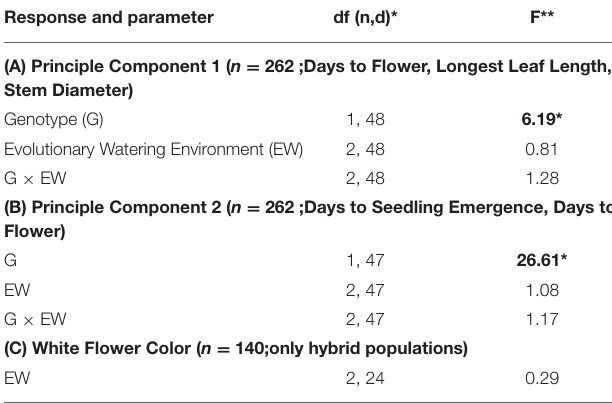
TABLE 4 | Mixed model ANOVA of mean evolutionary divergence rates of (A) principle component 1 (PC1), (B) principle component 2 (PC2), and (C) white flower color.